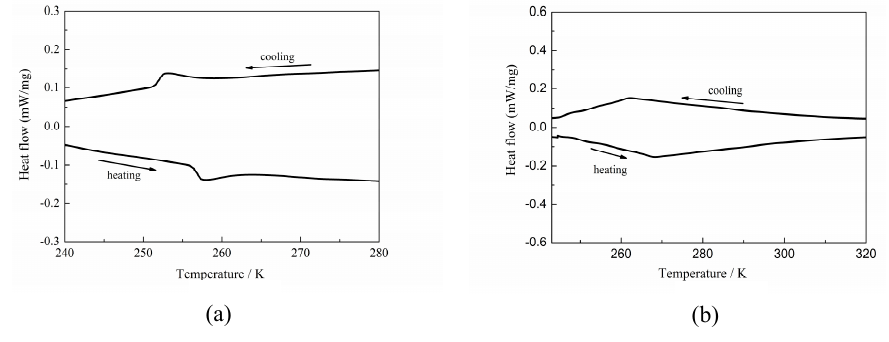
Figure 5. DSC curves of crystal 1 ( a ) and crystal 2 ( b ) in a heating-cooling cycle.